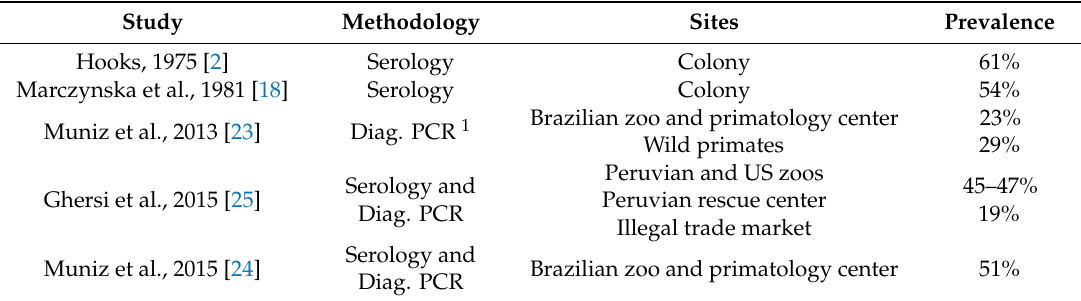
Table 2. Simian foamy virus prevalence in neotropical primates.